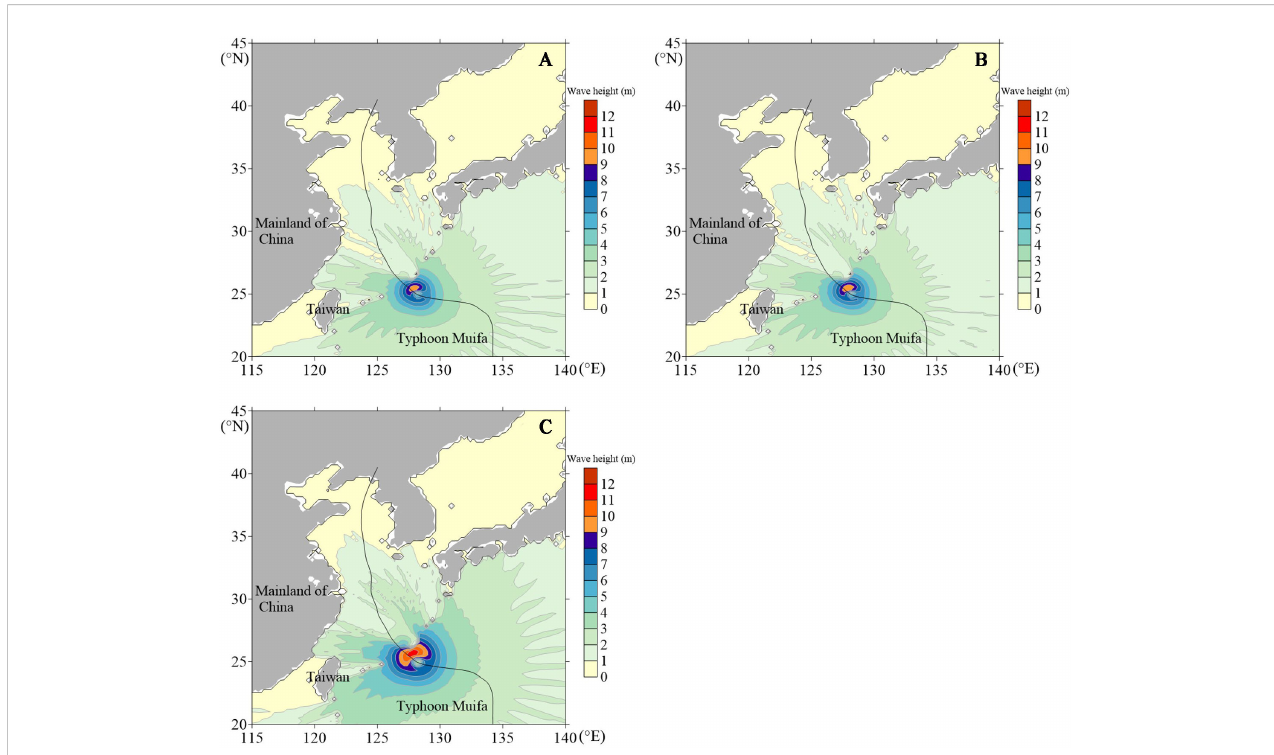
FIGURE 7 Distribution map of the wave fi eld of Typhoon Muifa at 1800 UTC 4 August 2011: (A) symmetrical wind fi eld, (B) superimposed wind fi eld, (C) asymmetric wind fi eld.